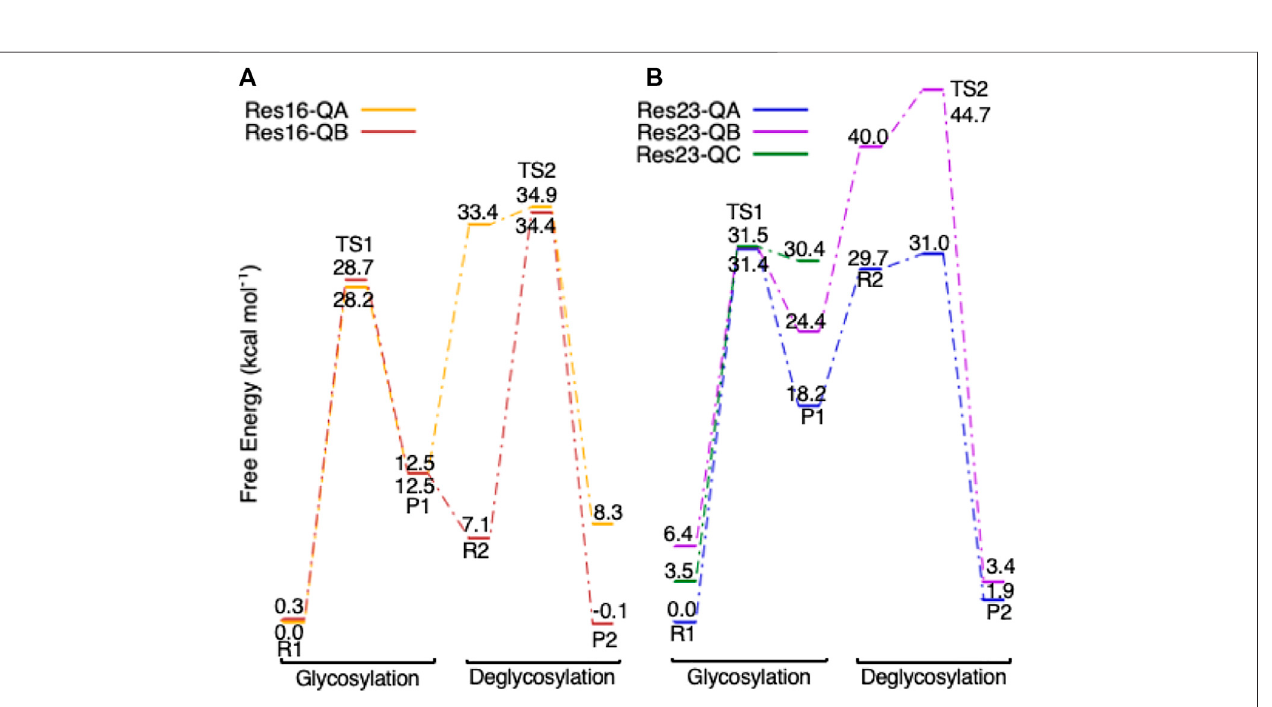
Frontiers in Chemistry |